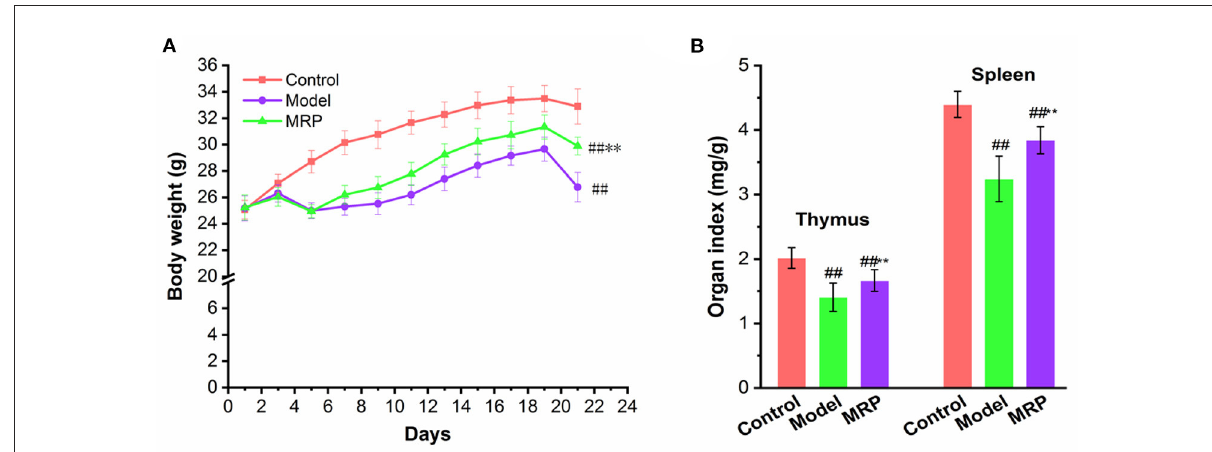
FIGURE4 Effect of MRP on body weight (A) and immune organ index (B) in CTX-treated mice ( n = 10). ## P < 0.01 vs. Control; ** P < 0.01 vs. Model.